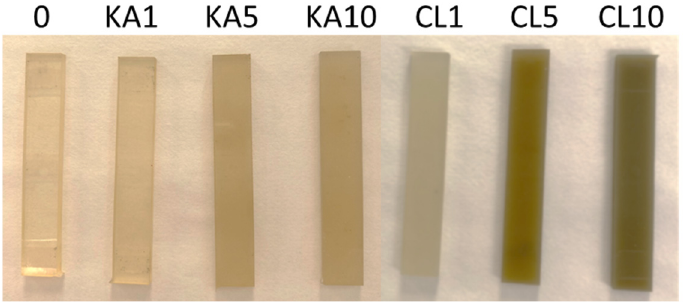
Figure 9. Samples after DMA analysis.